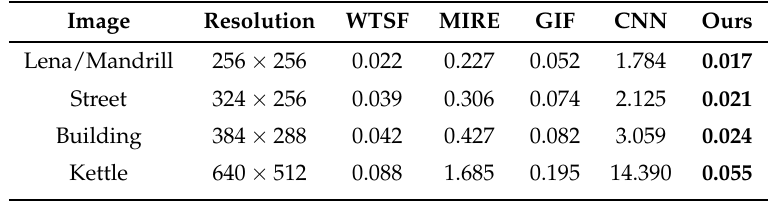
Table 5. Computing time (s) of different methods for simulated and raw IR images.